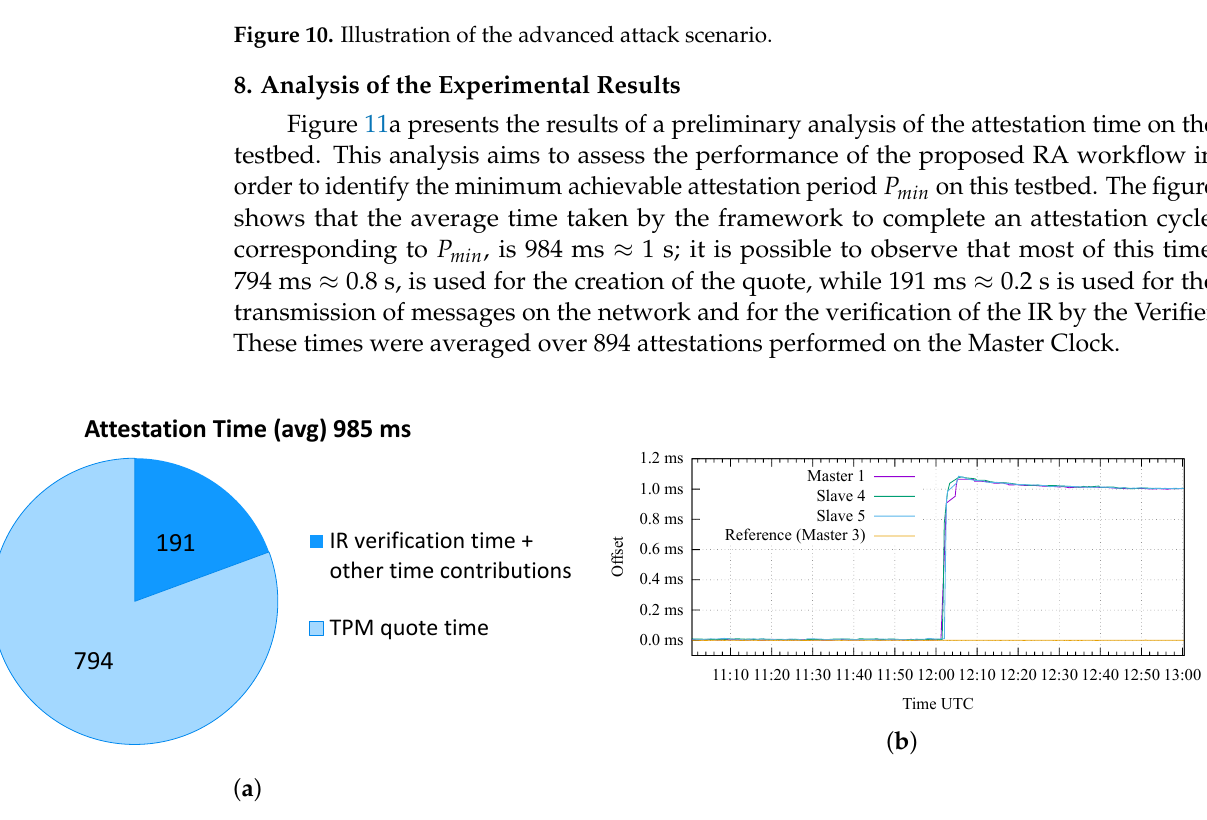
Figure 11. Obtained results for ( a ) assessment of the attestation time and ( b ) basic attack